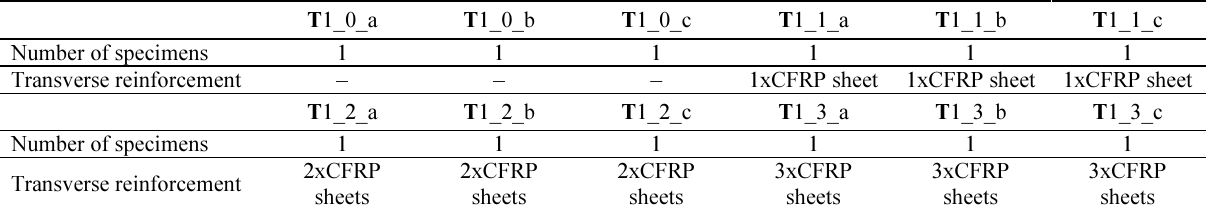
Table 2 . Investigations program at stage I